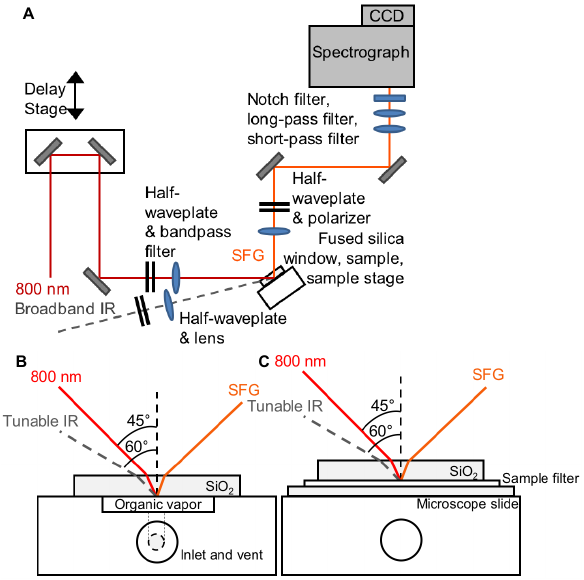
Figure 1 Fig. 1. (A) Schematic of the optical layout used for the vibrational sum frequency generation (SFG) experiments. (B) Top view of the sample cell used for collecting vibrational SFG spectra from the optical window/organic vapor interface. (C) Top view of the sam- ple cell used for collecting vibrational SFG spectra from the fused silica/filter sample